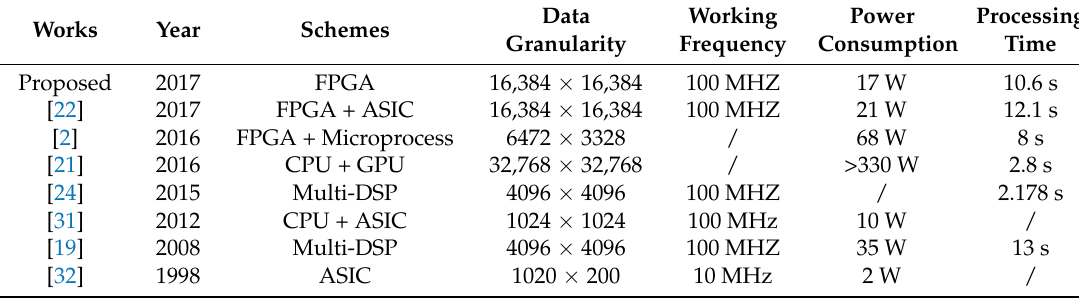
Table 7. Comparison with previous